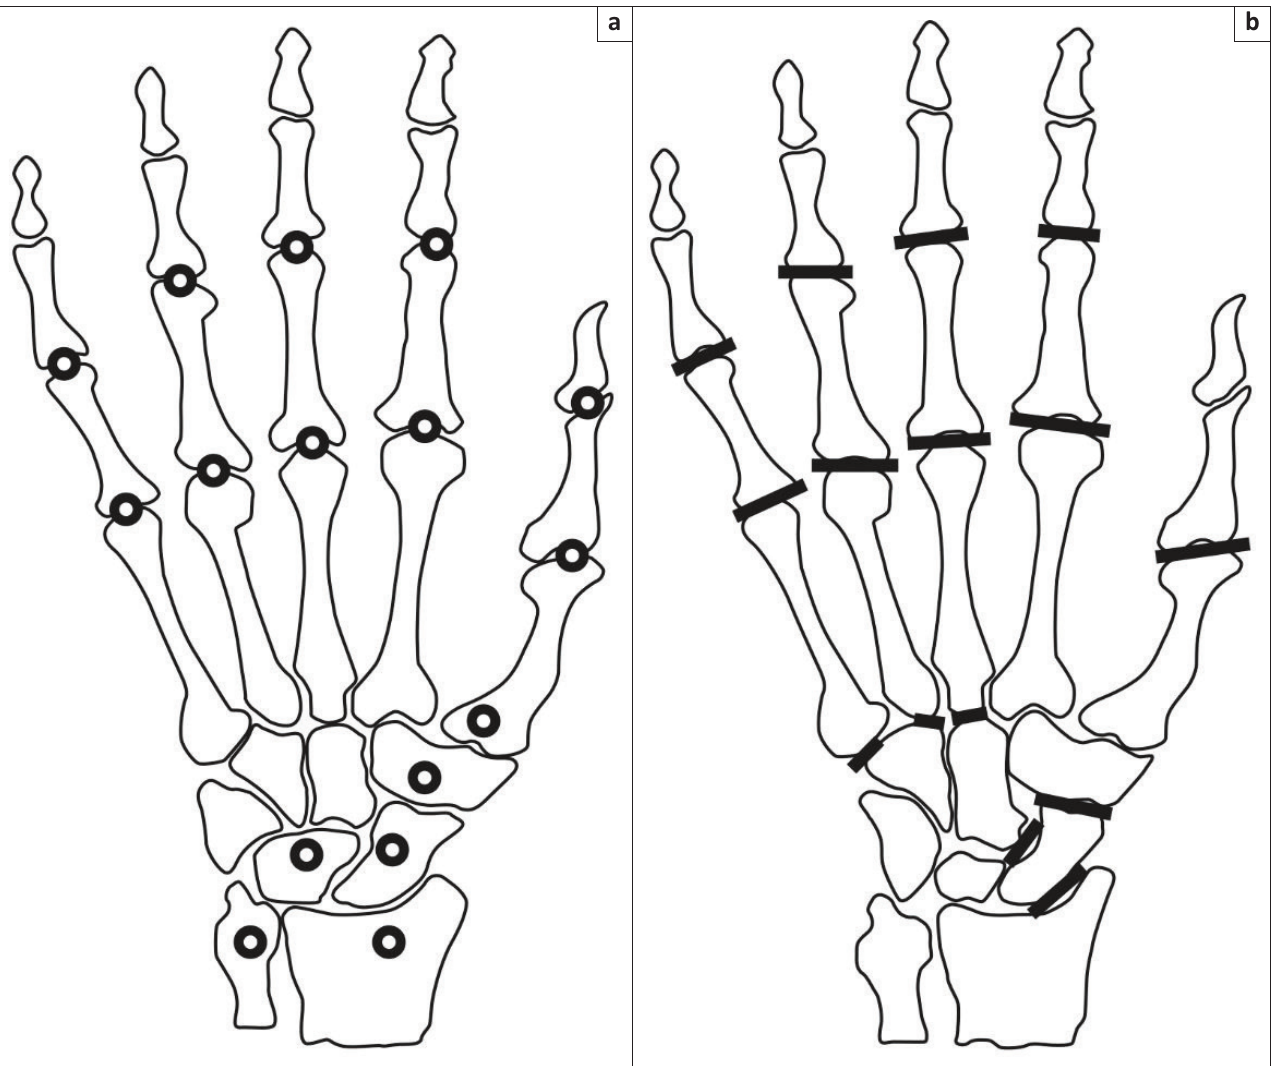
FIGURE 1: Diagram illustrating joints of the hand assessed for (a) erosions and (b) joint space narrowing for Simple Erosion Narrowing